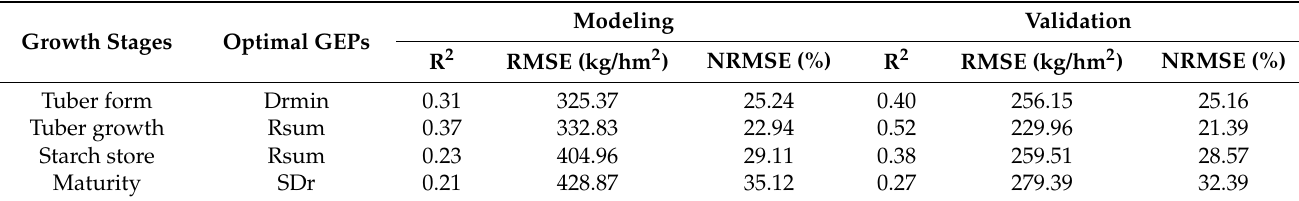
Table 3. Linear regression between optimal GEPs and potato AGB for the four growth